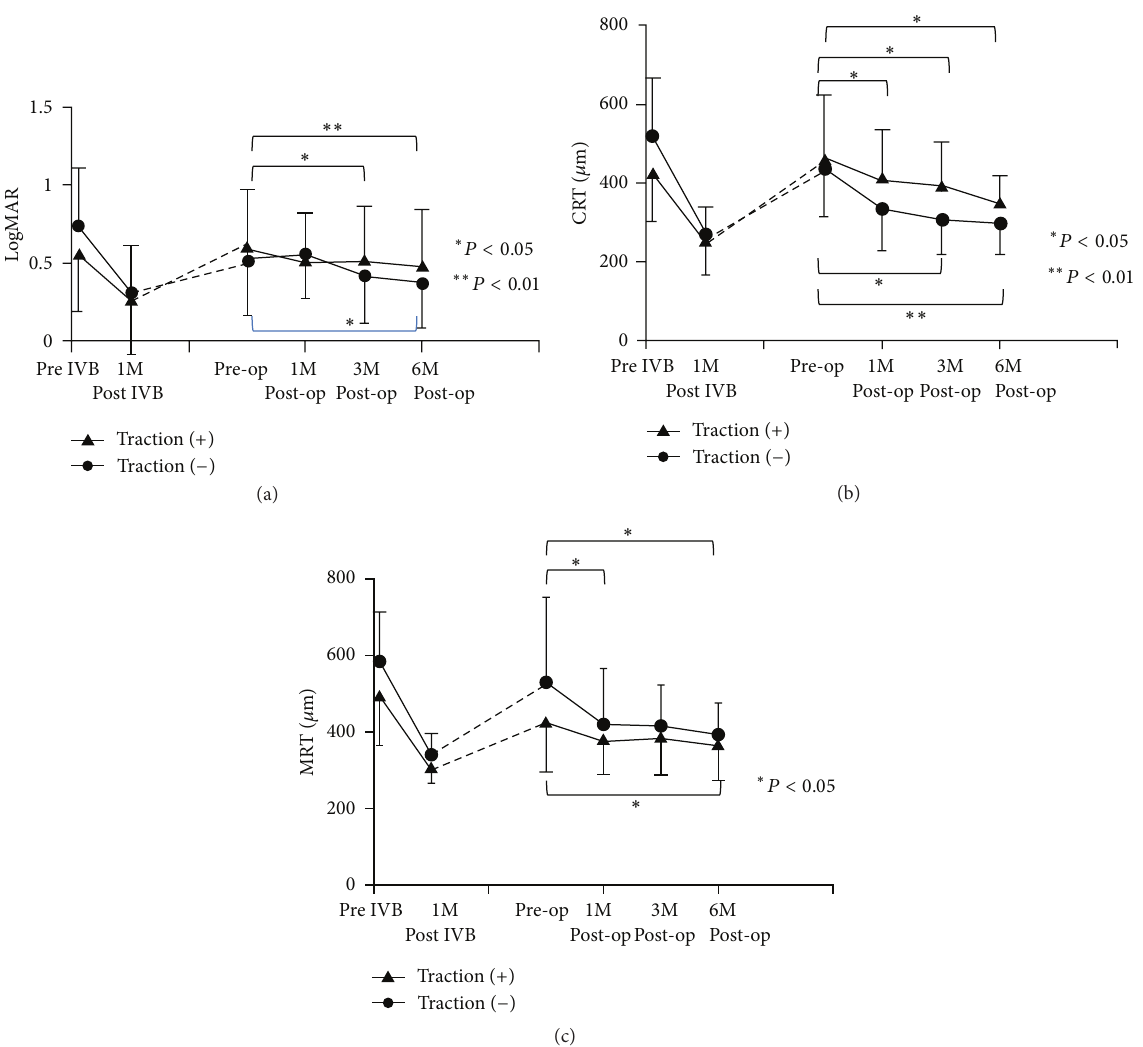
Figure 4: Changes in BCVA (a), CRT (b), and MRT (c) of two groups: one group of the eyes with apparent vitreomacular traction and/or an epiretinal membrane and the other group of the eyes without apparent vitreomacular traction. (a) Mean BCVA was significantly improved in both groups after vitrectomy ( ∗ 𝑃 < 0.05 , ∗∗ 𝑃 < 0.01 ). There was no significant difference between the two groups at any time point. (b) Mean CRT was significantly improved in both groups after vitrectomy ( ∗ 𝑃 < 0.05 , ∗∗ 𝑃 < 0.01 ). There was no significant difference between the two groups at any time point. (c) Mean MRT was significantly improved in both groups after vitrectomy ( ∗ 𝑃 < 0.05 ). There was no significant difference between the two groups at any time